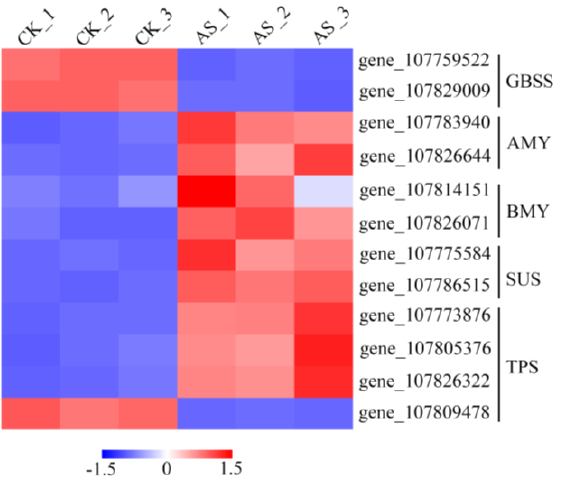
Figure 7. Heatmap of specifically expressed genes related to the “starch and sucrose metabolism” pathway in the AS treatment. pathway in the AS